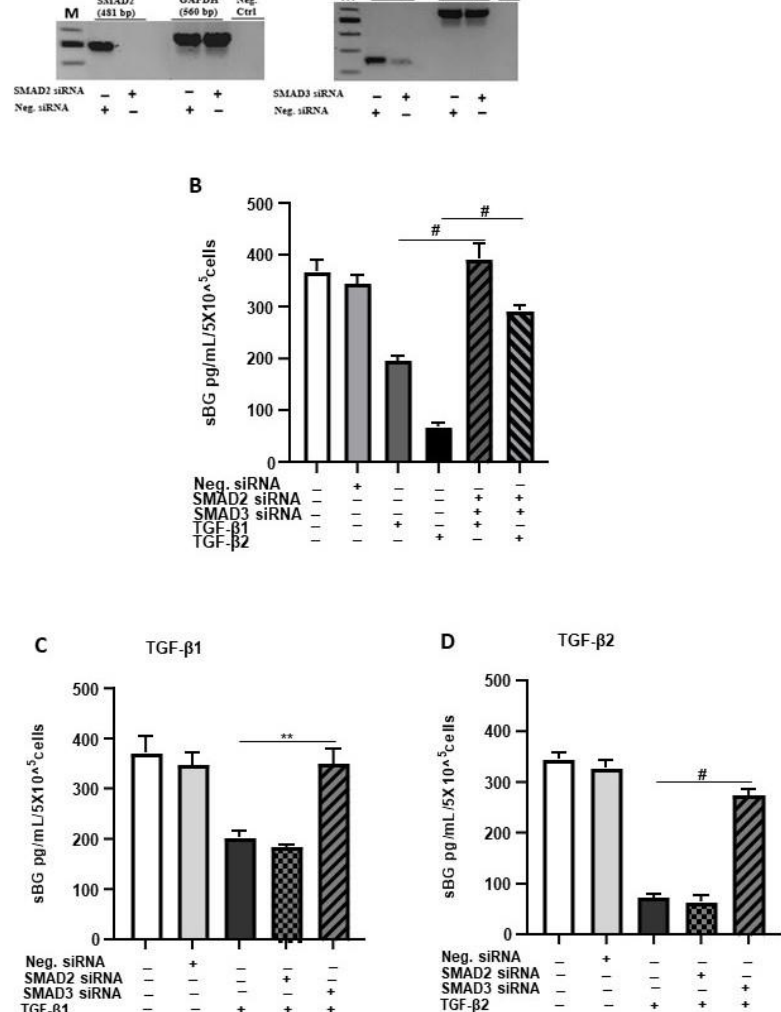
Figure 3. TGF- β 1/2-mediated reduction in BG shedding is SMAD3- but not SMAD2-dependent. Epithelial 12Z cells were plated in 6-well plates and transfected with SMAD2 siRNA, SMAD3 siRNA or negative control siRNA and a control RT-qPCR of the gene silencing efficiency for each siRNA performed to ascertain silencing of SMAD2 and SMAD3 ( A ). SMAD2/3 double-silenced ( B ) and single-silenced ( C , D ) epithelial 12Z cells were stimulated with TGF- β 1 or TGF- β 2 (10 ng/mL) for 48 h, and supernatants were analyzed by sBG ELISA. SMAD2/SMAD3 double gene knockdown significantly abrogated the TGF- β 1 and TGF- β 2-dependent reduction in BG shedding ( B ). Analysis of individual knockdowns revealed that silencing of SMAD3 gene and not of SMAD2 gene abolished the TGF- β 1- and TGF- β 2-mediated reduction in BG shedding ( C , D ). Each bar represents the mean ± SEM of three independent experiments performed in duplicate. ** p < 0.01; # p < 0.0001; M, DNA ladder; Neg. siRNA, control siRNA; Neg. Ctrl, negative control; bp, base pairs; sBG, soluble